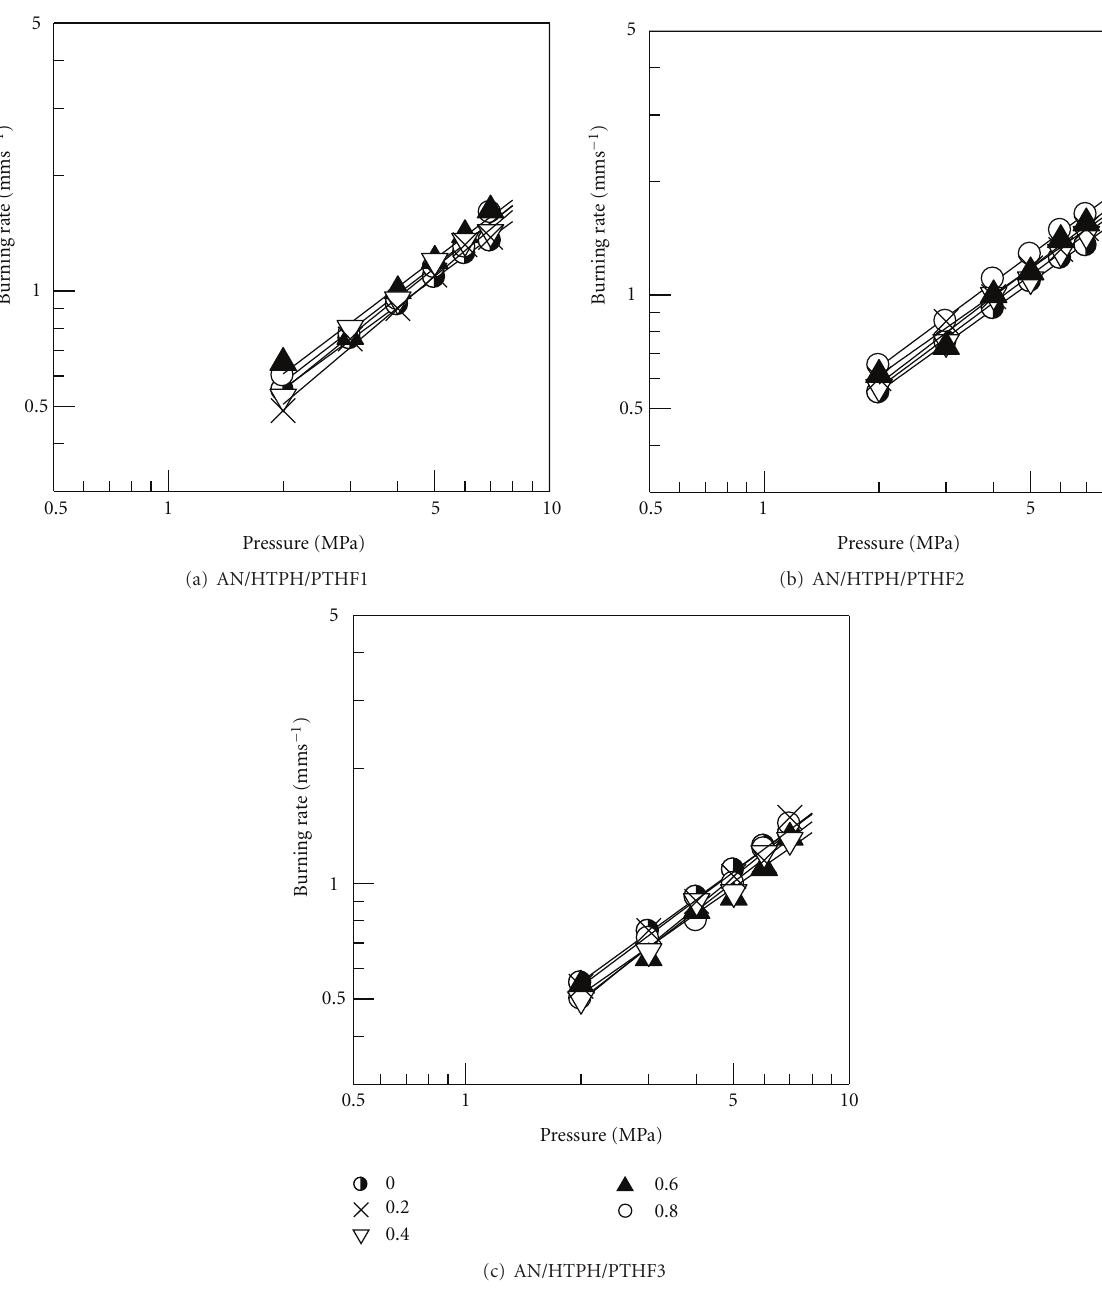
Figure 1: Burning rate characteristics of